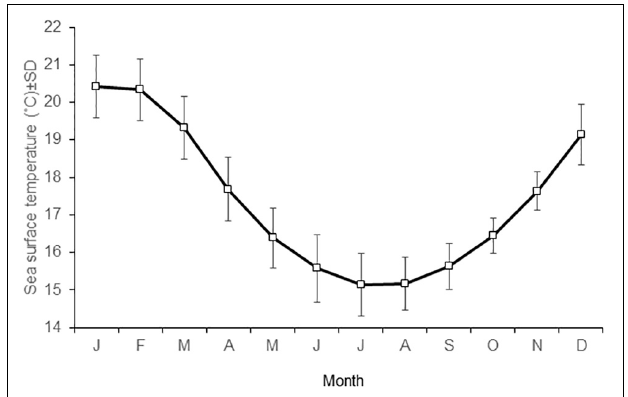
FIGURE 2 | Seasonal variability in mean sea surface temperature in Antofagasta Bay. Monthly values represent the mean value (and standard deviation) for the period